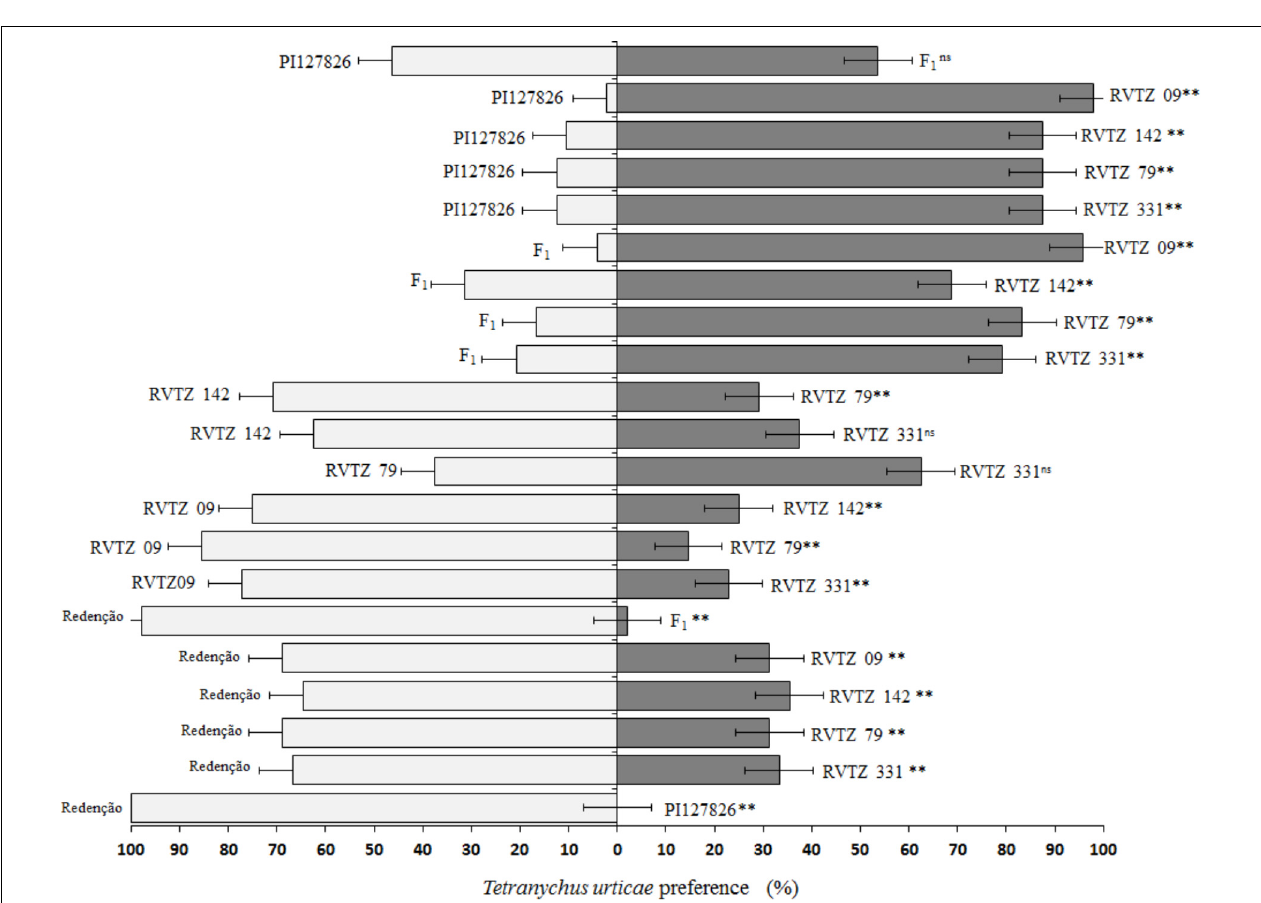
FIGURE 2 | Preference ratios (%) of Tetranychus urticae on the 21 different pairwise combinations of tomato genotypes during the free-choice test. Redenção = S. lycopersicum cv. Redenção, PI127826 = S. habrochaites var. hirsutum accession PI-127826, F 1 = F 1 plant (PI-127826 × cv. Redenção), RVTZ-09 = RVTZ 2011-09 (low ZGB content), and RVTZ-79, RVTZ-142, and RVTZ-331 = RVTZ2011-79, RVTZ2011-142, and RVTZ2011-331, respectively (genotypes with high ZGB content). ns non-significant different, and ∗∗ significant different ( p < 0.01) using Pearson’s Chi-Square test ( χ 2 ).